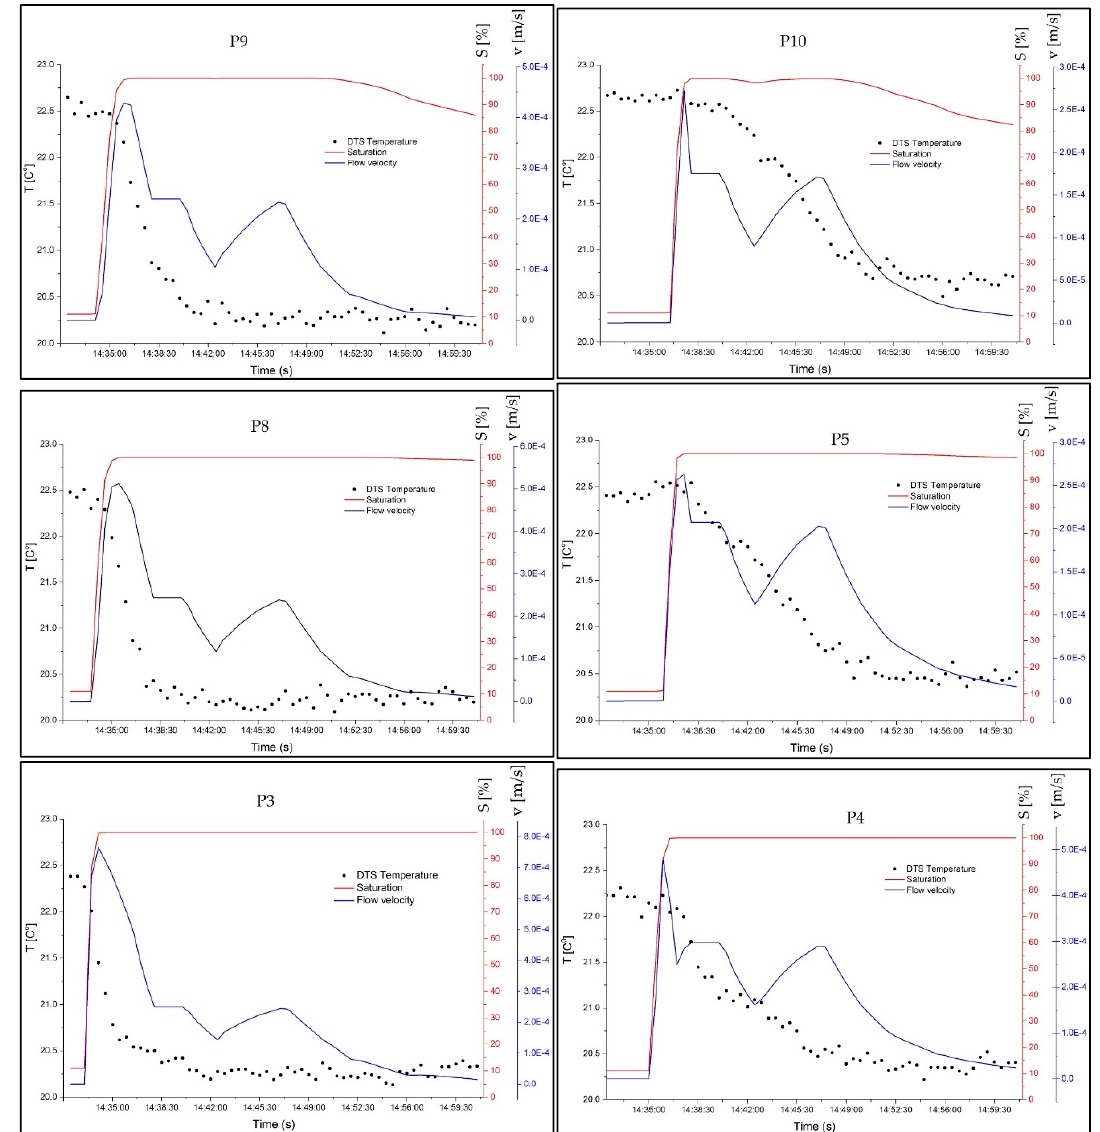
Figure 11. Measured temperature by optical fiber DTS, the calculated degree of saturation and flow velocity by the numerical modeling. The results are shown for six measuring points at three different elevations.